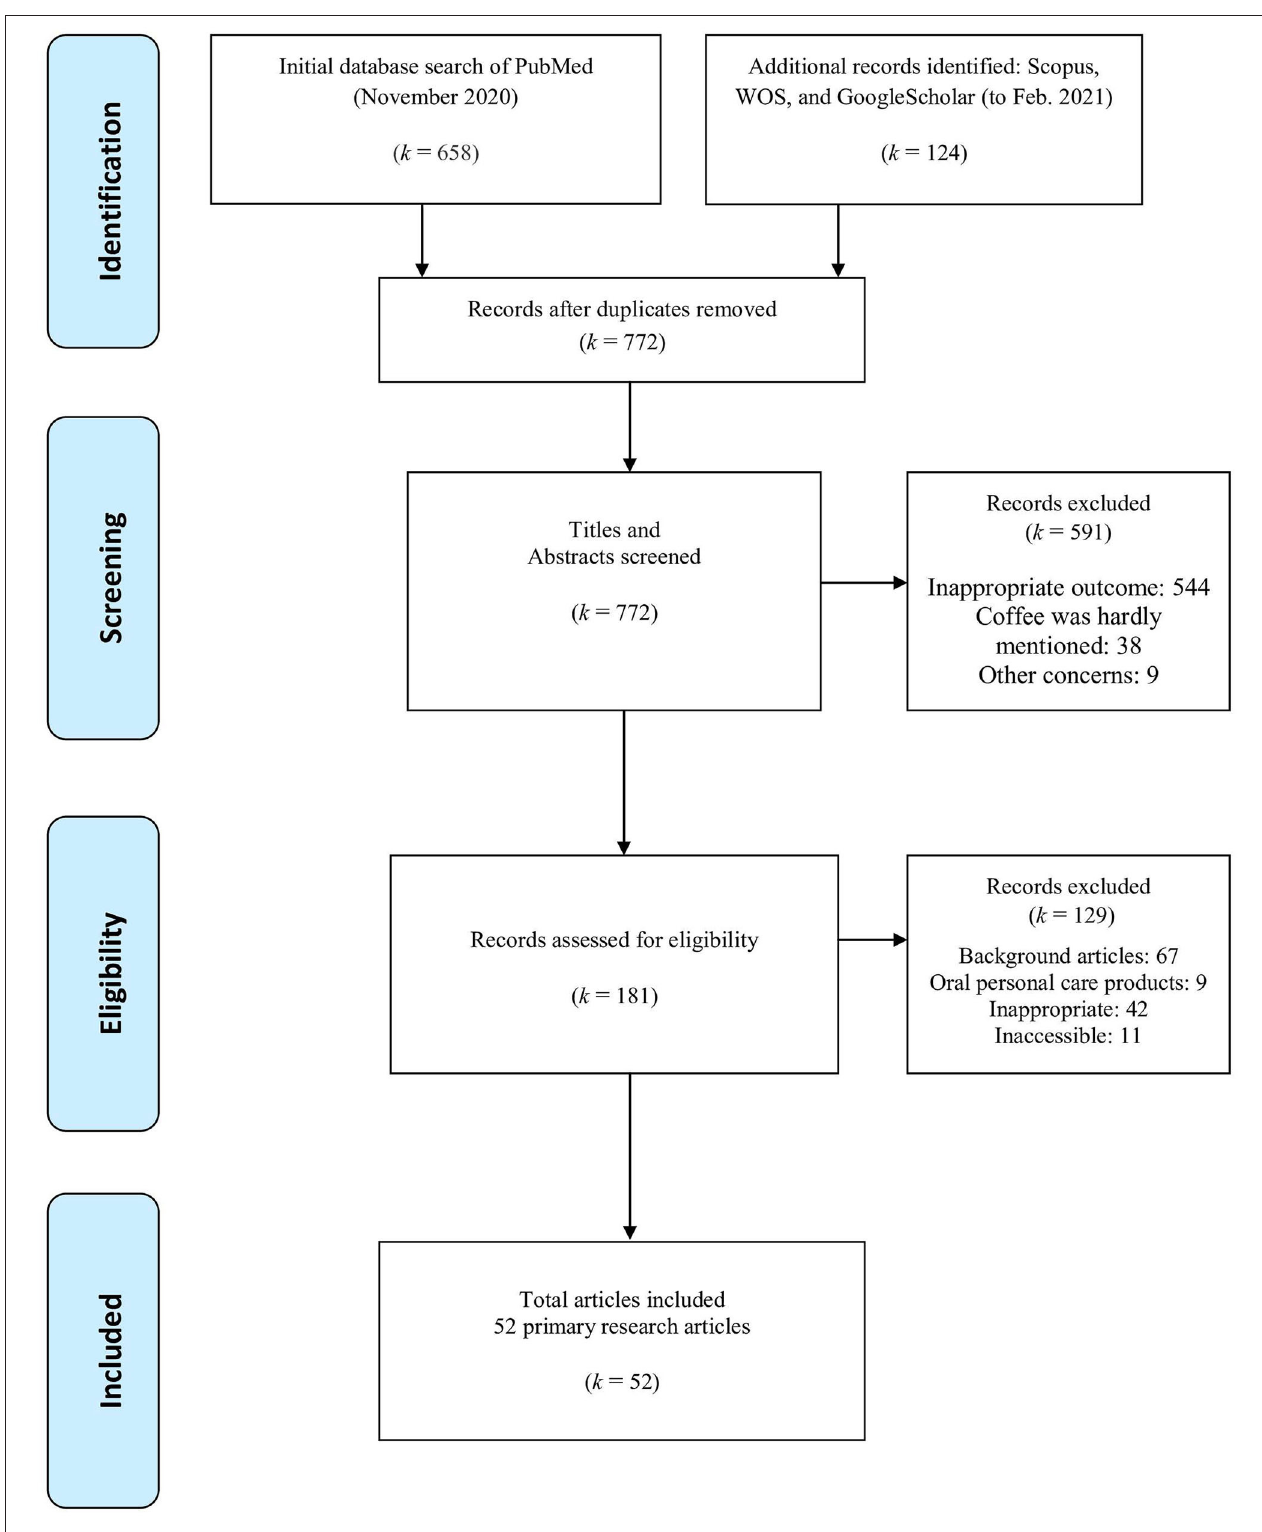
FIGURE 1 | PRISMA flow